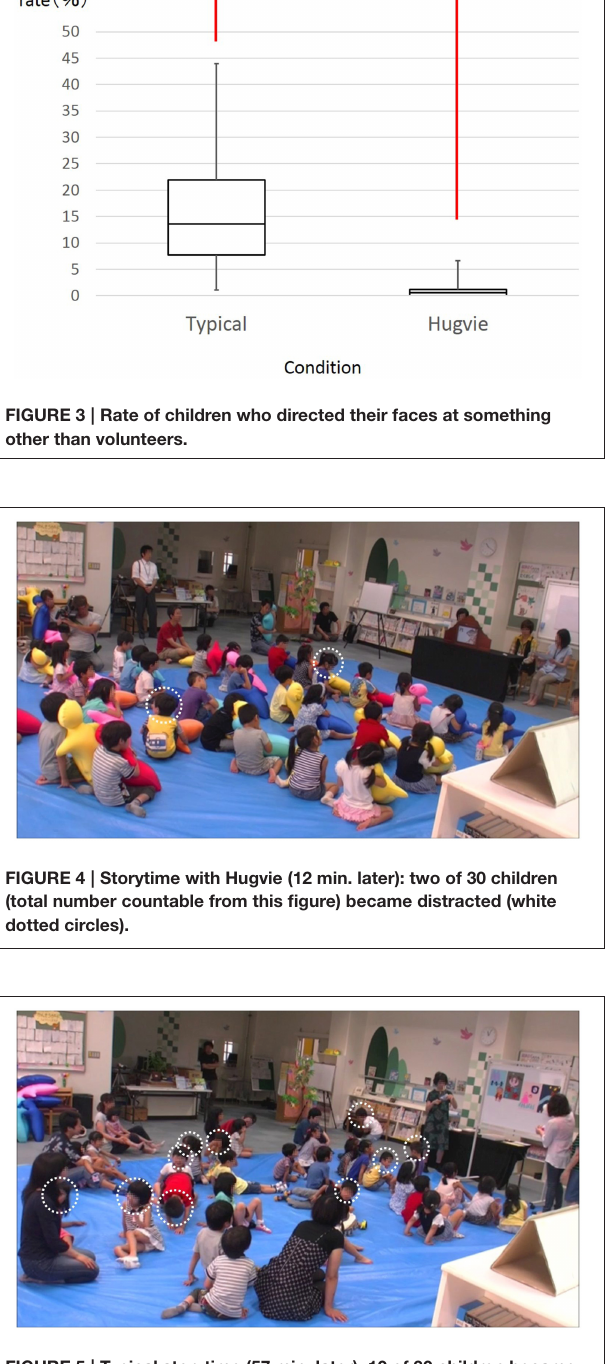
FIGURE 5 | Typical storytime (57 min. later): 10 of 30 children became distracted (total number countable from this figure) (white dotted